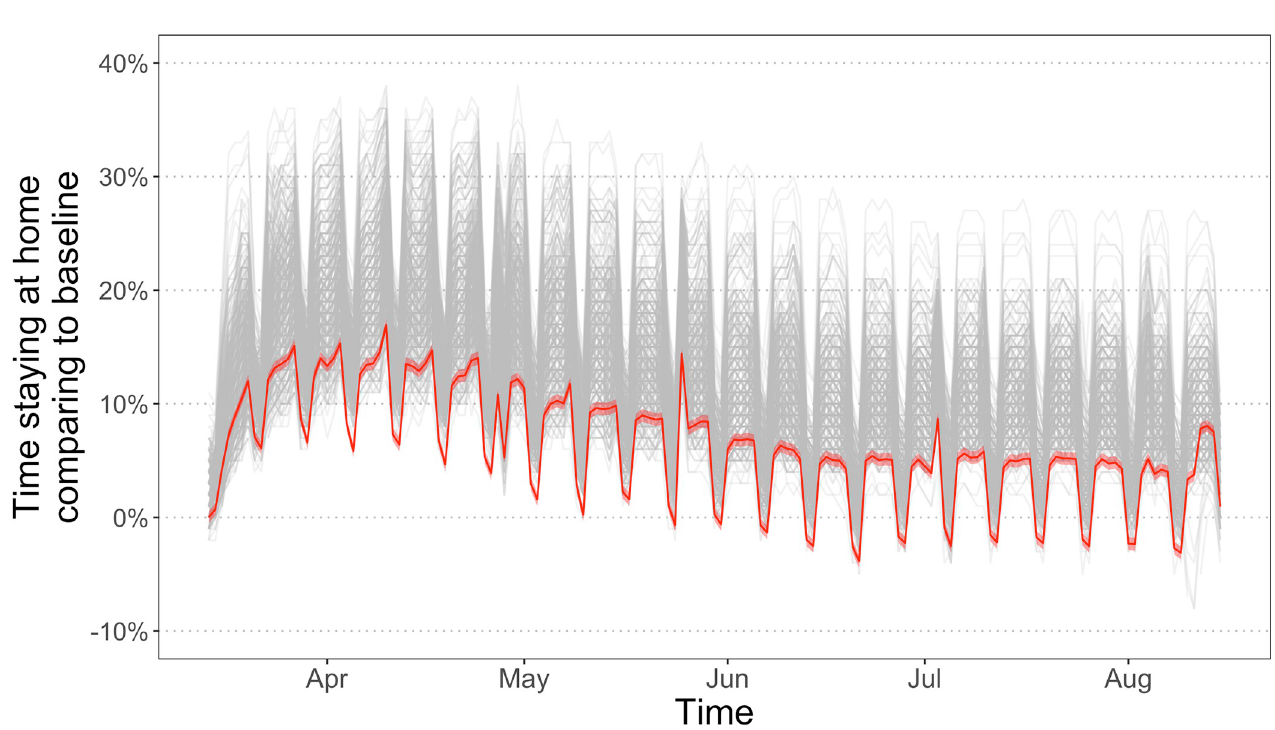
Fig 2. Trend of the common change in residents’ mobility. Grey lines are the daily values of the Google mobility indicator in the sample counties and the red line is the common daily mobility change shared by the counties with 95% confidence interval. The red line demonstrates that there is a non-zero common trend of mobility across counties. Please note that the baseline in the Google mobility indicator is the median value on each day of the week from the 5-week period Jan 3 to Feb 6, 2020, in other words, different baselines are used for different days of the week.